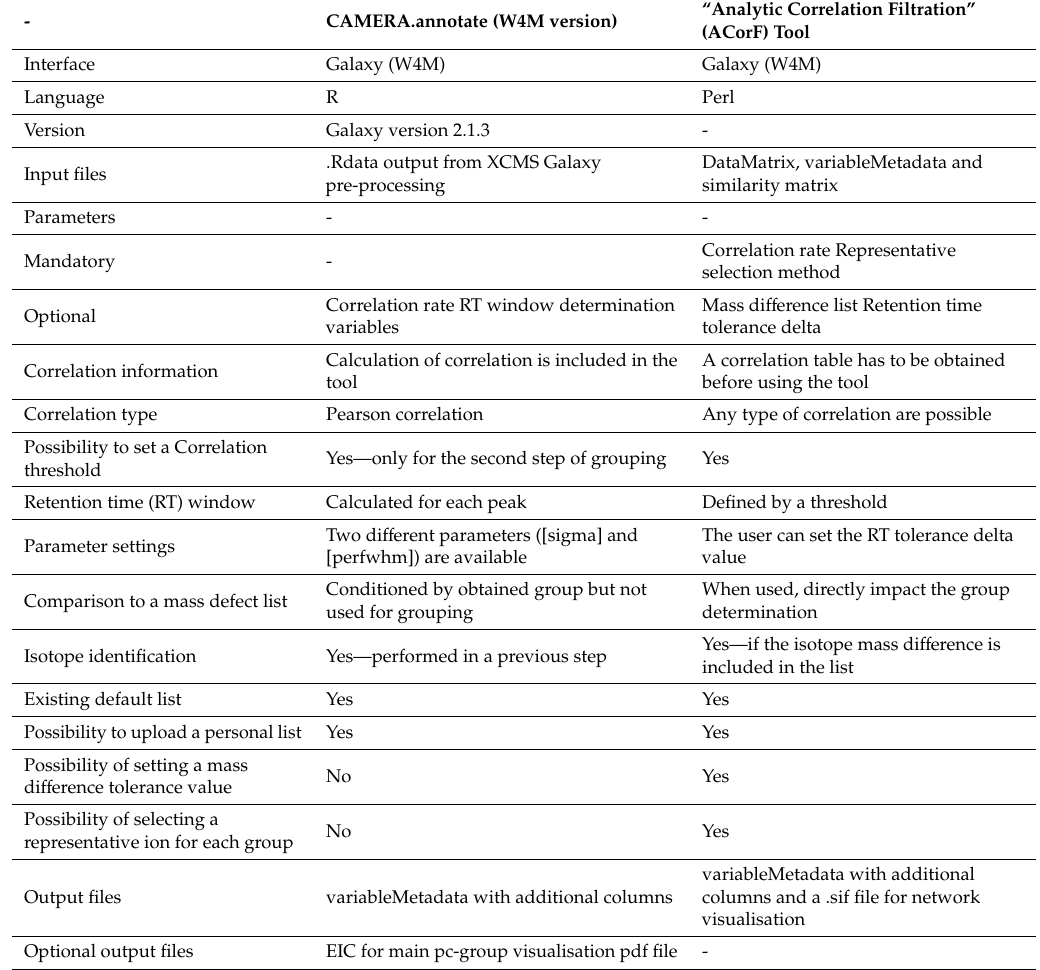
Table 1. Comparison of the CAMERA.annotate and ACorF tool